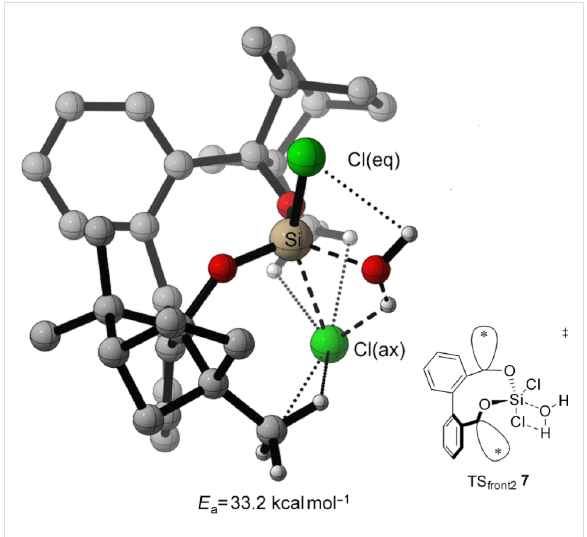
Figure 7: Transition state leading to 8 ax following front2 attack ( E a = 33.2 kcal mol − 1 , Figure 5, Table 3, entry 2). Breaking and forming bonds in dashed lines, additional C–H-interactions with dotted lines (M06-2X-D3/6-311++G(d,p)(PCM=THF)//B3LYP-D3BJ/6-31G(d) at 298